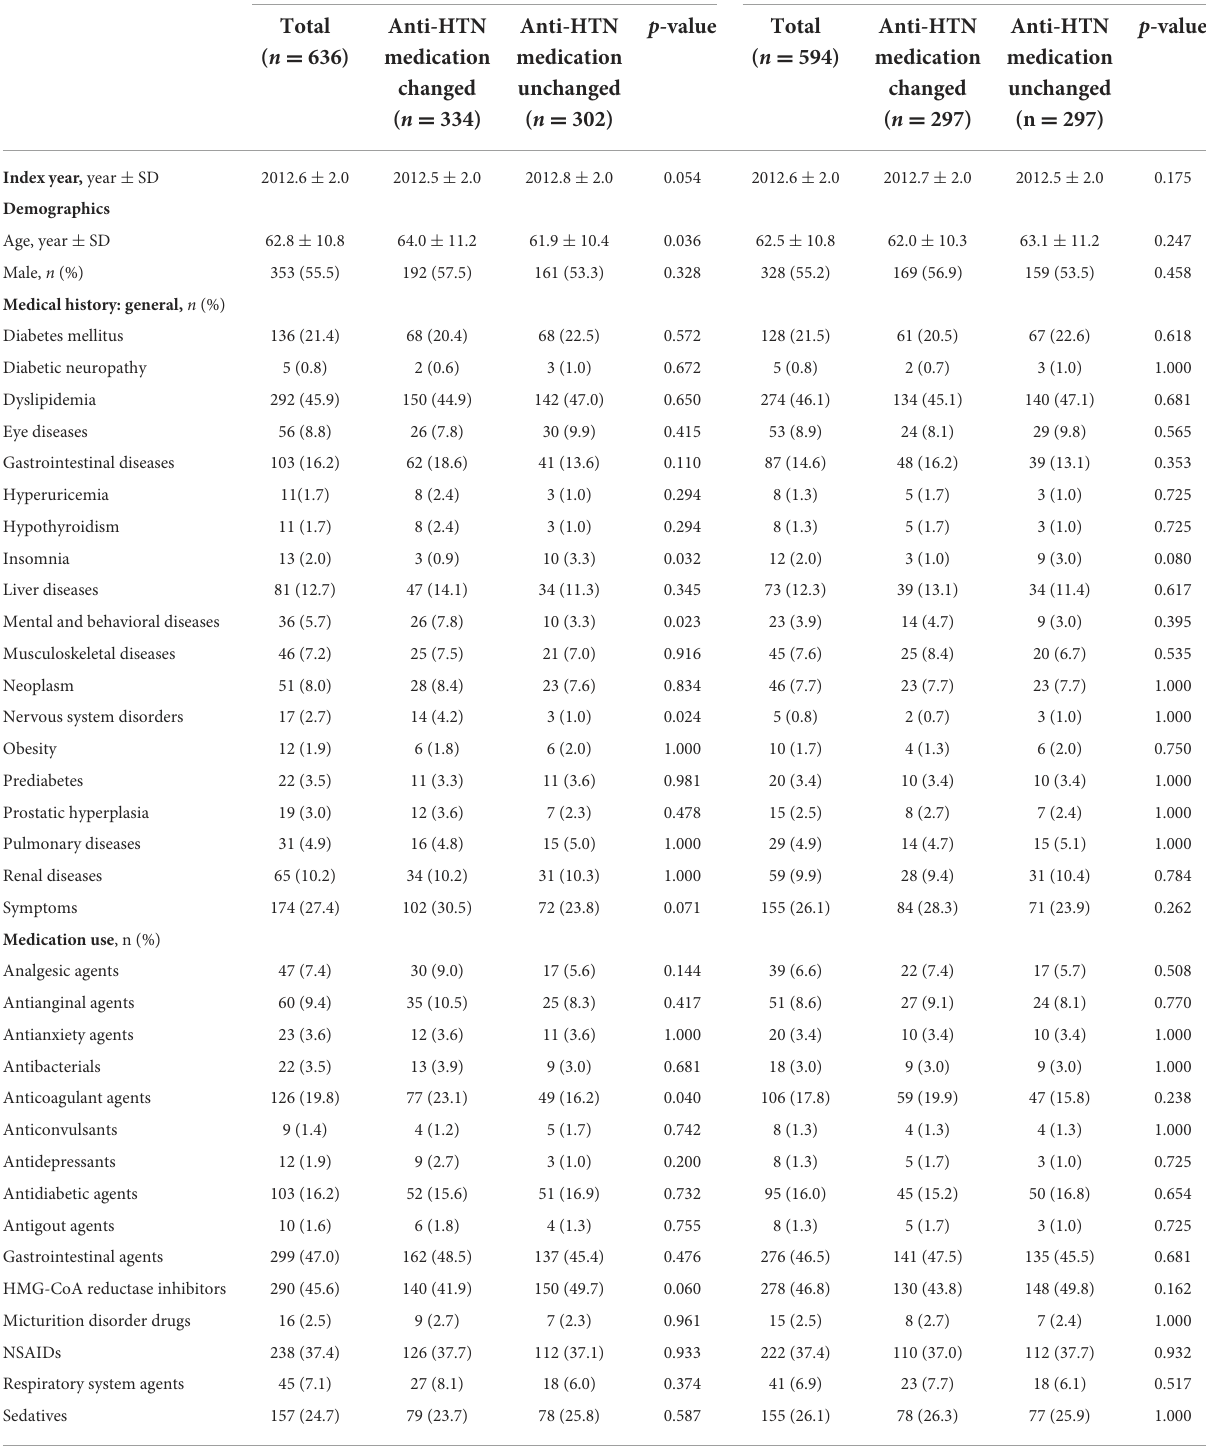
TABLE 1 Baseline